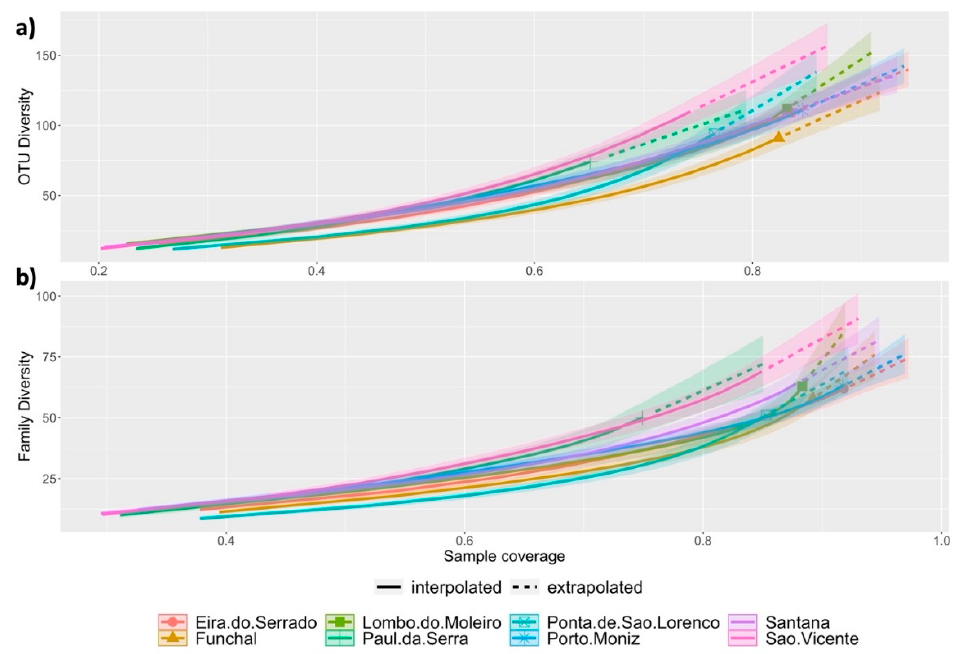
Figure 4. Rarefaction curves for population at the OTU ( a ) and family ( b ) levels, showing the observed (full line) and estimated (dashed line) richness, until double the reference sample size, and respective 84% confidence interval by sample coverage.